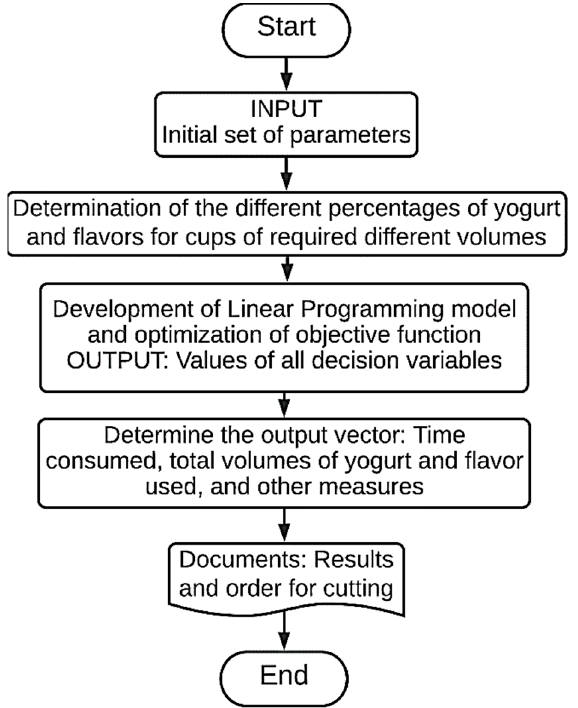
Figure 3. Optimal solution algorithm.